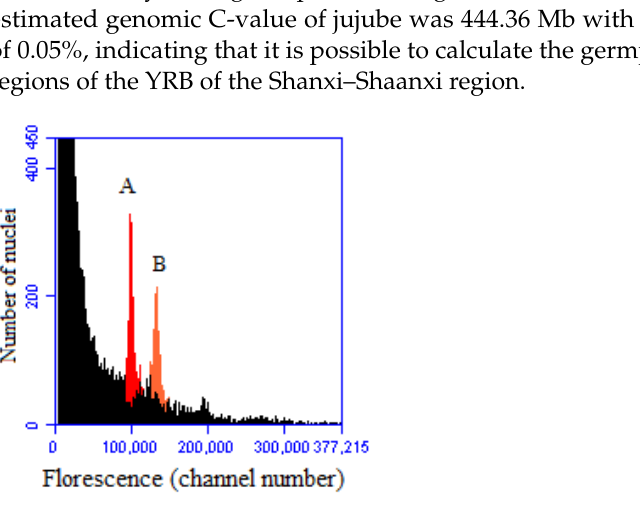
Figure 1. Histogram of measurements of the mixed sample. A: ‘Dongzao’; B: ‘Shanxi Duli.’ .